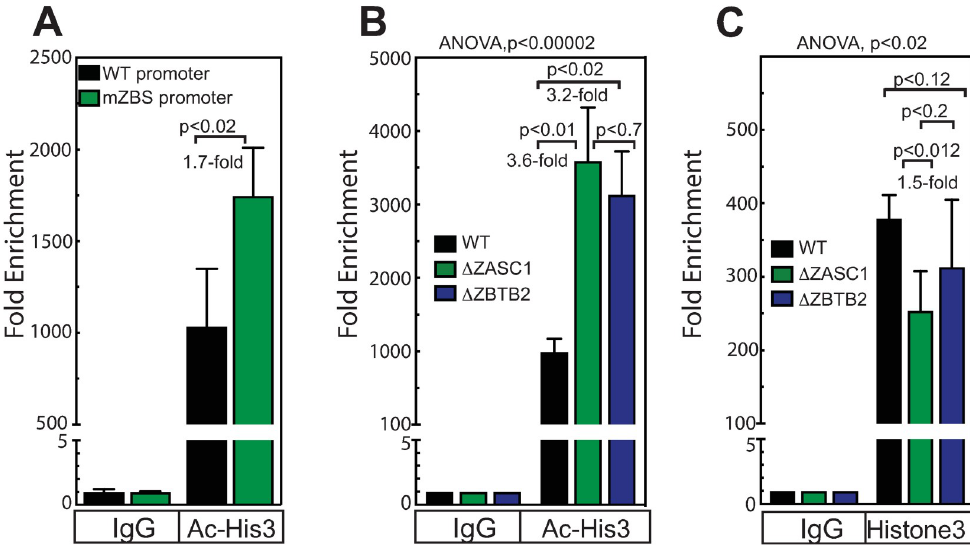
Fig 9. ZBTB2 regulates histone acetylation at the HIV-1 promoter. ChIP analysis of (A) histone H3 acetylation for the HIV-1 promoter in WT Jurkat cells infected with an HIV-1 vector with either a WT LTR or an LTR variant with all four ZASC1 binding sites mutated. ChIP analysis of (B) histone H3 acetylation and (C) total histone H3 on the HIV-1 promoter in HIV-1 vector infected WT Jurkat, Jurkat ZASC1 knockout cells and Jurkat ZBTB2 knockout cells. Immunoprecipitation and Real-time PCR analysis were performed and normalized to input controls as a percentage of starting material for immunoprecipitation and fold enrichment of experimental IPs relative to IgG controls reported. For each panel, the data shown are the average mean values obtained in an experiment performed with quadruplicate samples and are representative of three or more independent experiments. Error bars indicate the standard deviation of the data in all panels. For (A), P-values were calculated using a standard Student’s t-test and significant changes are indicated, for (B & C) ANOVA analysis was performed and for P-values < 0.05 a Tukey’s HSD was performed and relevant P-values reported.